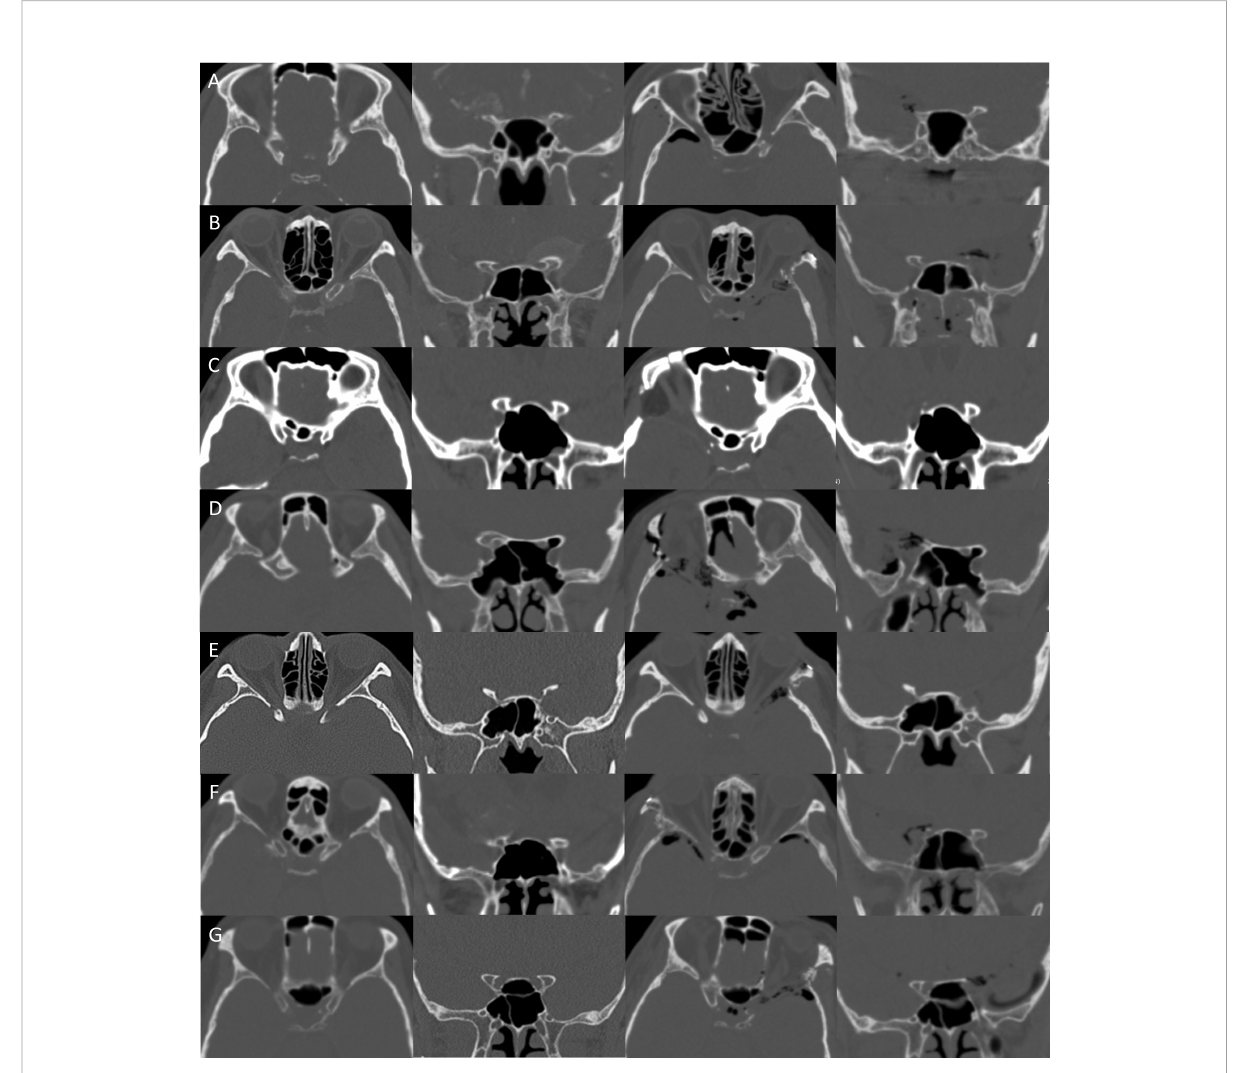
FIGURE 7 Clinical implication. (A – G) In seven cases, the stepwise extradural anterior clinoidectomy was completed. Complete removal of the ACP was con fi rmed with postoperative CT. CT, computed